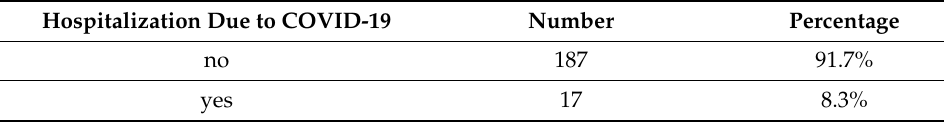
Table 2. Hospitalisation due to COVID-19.